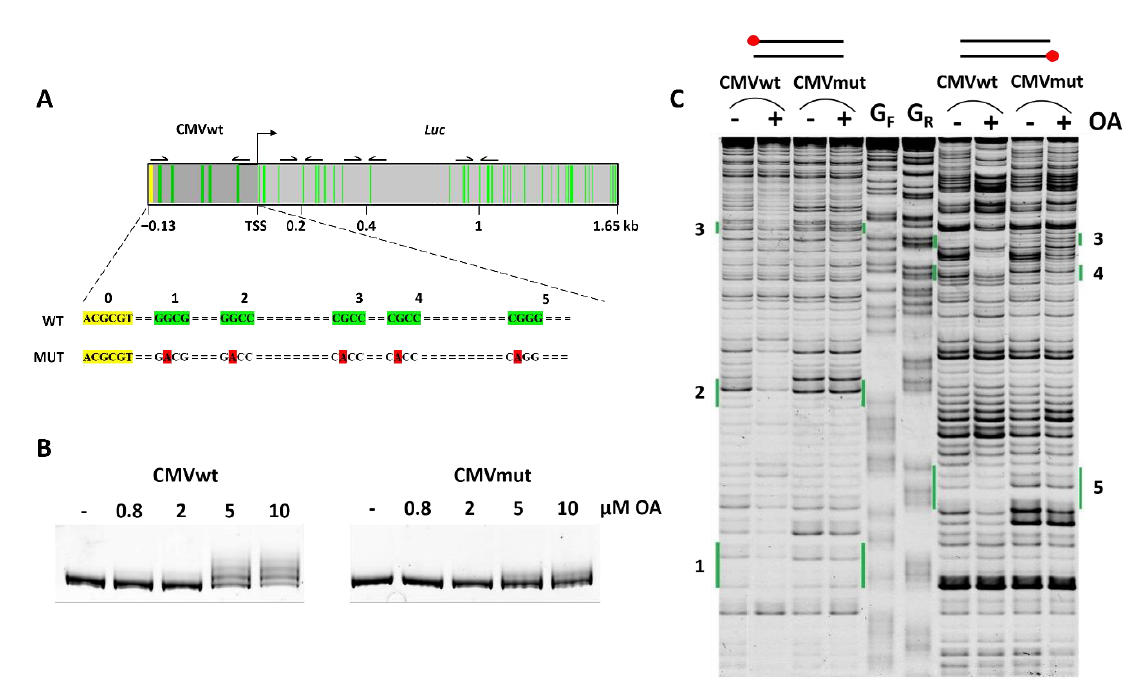
Figure 1. GC tetrads as sites of OA – DNA complex formation. ( A ) Tentative OA binding sites in minimal CMVwt promoters are marked in yellow and green. The yellow site used for cloning remained intact whereas in sites 1 – 5 (green) guanine residues were substituted for adenine (red). ( B ) EMSA of OA complexes with CMVwt and CMVmut DNA fragments. Note the more slowly migrating DNAs after incubation of CMVwt fragment with 5 µM or 10 µM OA. ( C ) DNase I probing of CMVwt and CMVmut fragments. Forward (left) or reverse (right) strands were 5′ -end labeled with FAM (red circles). G F and G R are guanine sequencing lanes for the sense and complementary strands, respectively, obtained by treatment of DNA fragments with dimethylsulfate (see text and Section 3 for details). Positions of tetranucleotides 1 – 5 are shown in green as in ( A ).